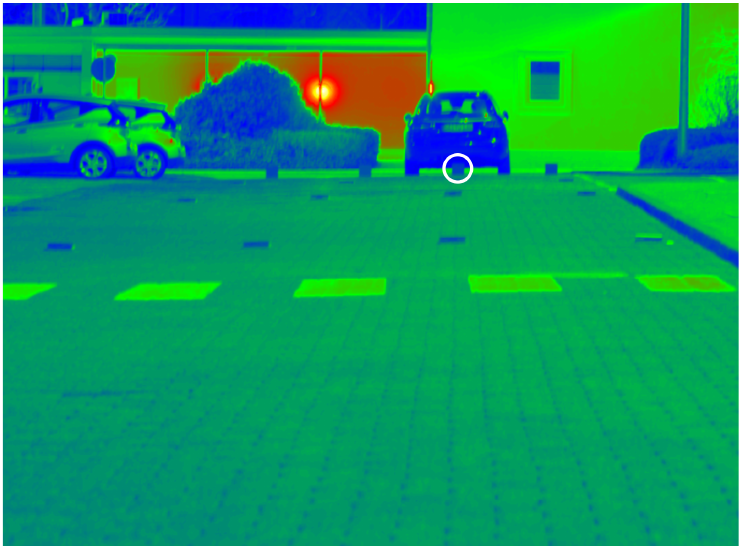
Figure 10. Object position 15 on test road 2; detection conditions are made more difficult by the position of the flat target directly in front of the fixation